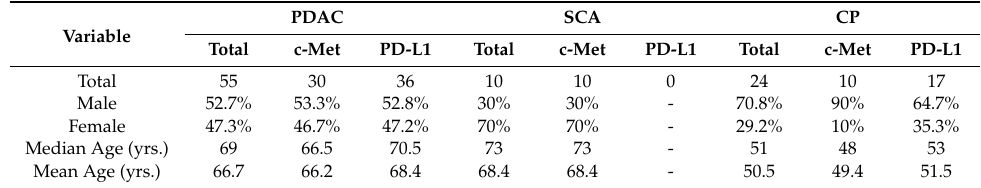
Table 1. Diagnosis, gender and age of the analyzed patient